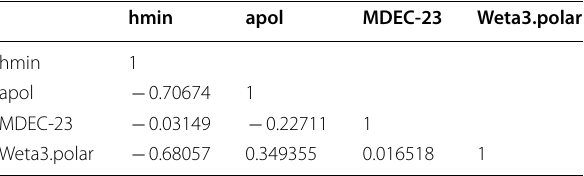
Table 4 Validation of the descriptors using Pearson’s